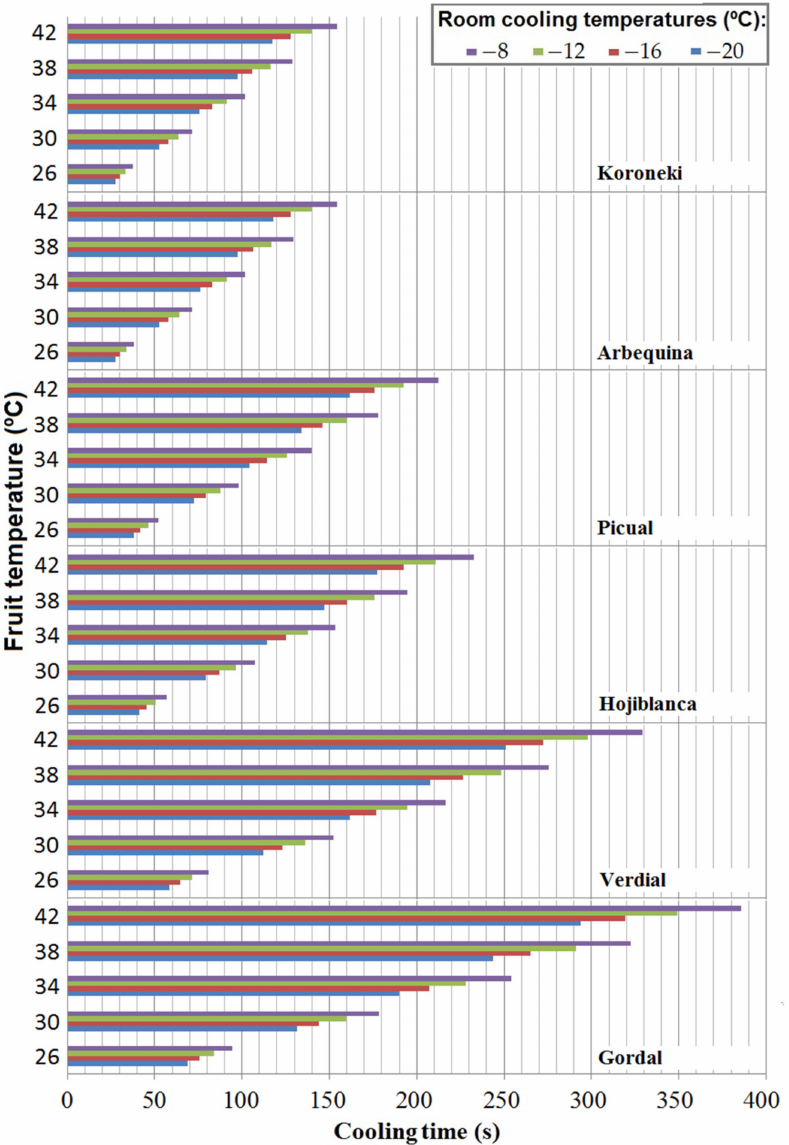
Figure 8. Cooling time needed to bring the olive fruit of 6 different cultivars down to 22 ◦ C, when cooled at different room cooling temperatures ( − 8, − 12, − 16, − 20 ◦ C) and at different initial temperatures (26, 30, 34, 38, 42 ◦ C). Half the cooling time (z) is calculated from the empirically constructed cooling curves of 25 olives from each